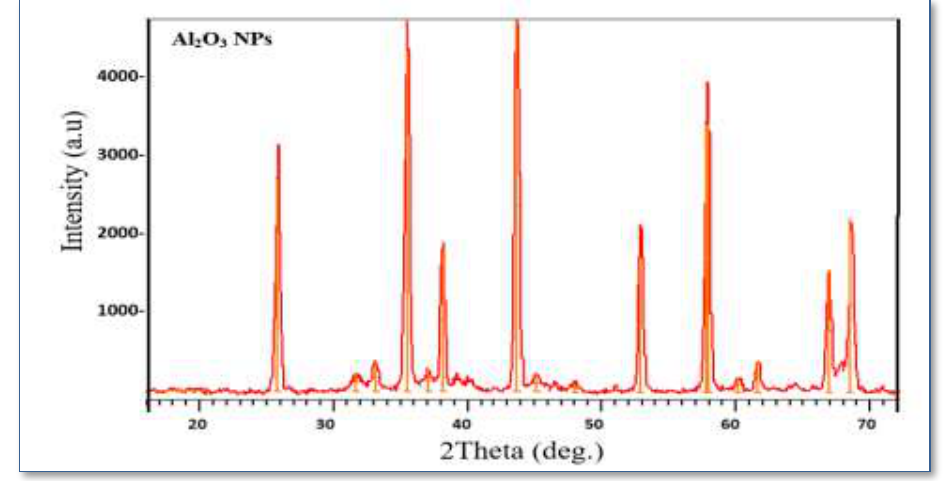
Figure 4: The XRD results of the crystalline structure of Al 2 O 3 NPs.